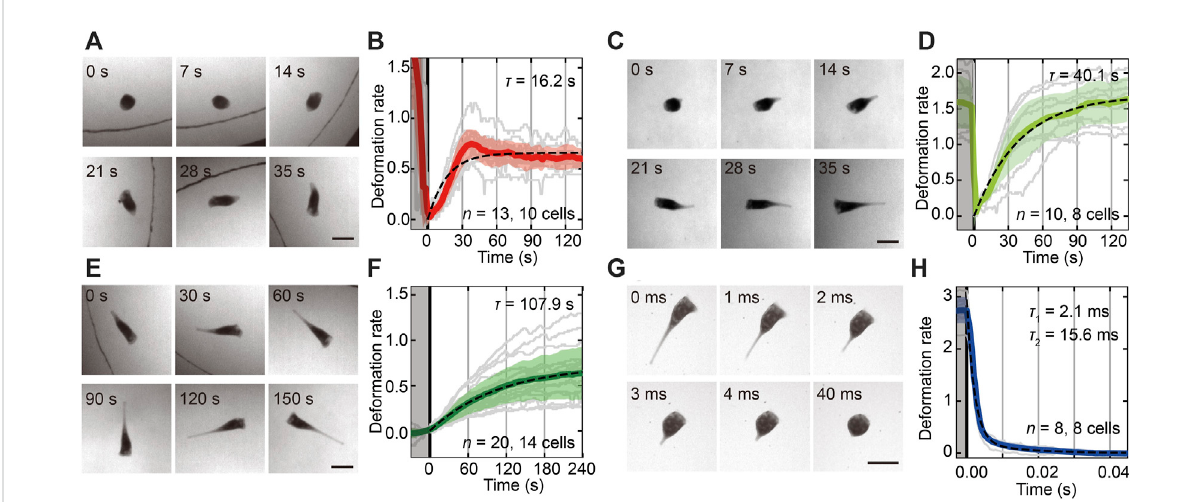
FIGURE 2 The shape transitions between the cell states and the estimation of each duration time of the transitions. (A,C,E,G) Sequential images of the shape transitions from droplet to cone (A) ,from droplet to trumpet (C) ,from cone to trumpet (E) and fromtrumpetto droplet (G) . The time isshown at the upper left in each image. The beginning time of the shape transition is adjusted at 0 s. In the transitions from droplet to cone (A) and cone to trumpet (E), the cell moves actively. The black curved line in (A) and (E) represents the boundary of the chamber. All bars are 0.2 mm. (B,D,F,H) Thetimeseriesofshapedeformationratesineachtransitionfromdroplettocone (B) ,fromdroplettotrumpet (D) ,fromconetotrumpet (F) and from trumpet to droplet (H) . The gray regions represent the sections before each transition. The colored solid lines are a time series of the averaged deformation rate. Individual data and the standard deviation of the rate are shown by gray lines and transparent colored regions, respectively. The duration times are estimated by exponential fi tting to the averaged deformation rate represented as black dashed lines. These characteristic times are 16.2 ± 0.2 s (SD, n = 13, 10 cells) from droplet to cone (A,B) , 40.1 ± 0.51 s (SD, n = 10, eight cells) from droplet to trumpet (C,D) , and 107.9 ± 1.47 s (SD, n = 20, 14 cells) from cone to trumpet (E,F). The duration time from trumpet to droplet (G,H) is estimated at 2.1